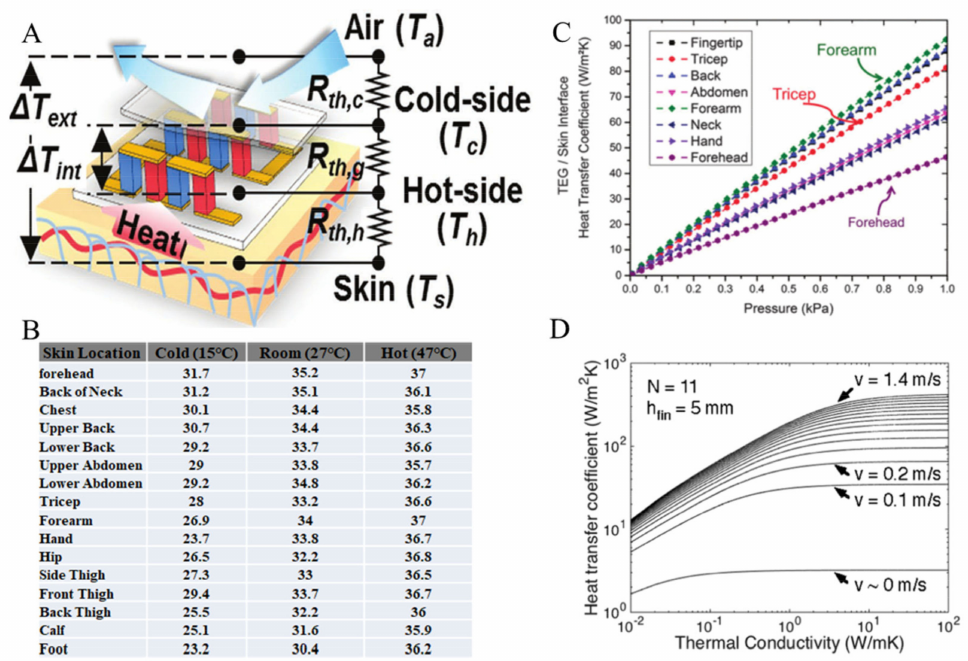
Figure 3. ( A ) Schematic for the heat transfer model of a wearable thermoelectric generator [37]. ( B ) Reported human skin temperatures for different points on the body at varying ambient tempera- tures. ( C ) Heat transfer coefficient of the TEG/skin interface as a function of pressure for various locations on the body [44]. ( D ) Heat transfer coefficient of a small heat sink plotted as a function of the thermal conductivity of the heat sink material for different air velocities ranging from almost 0 to 1.4 m/s